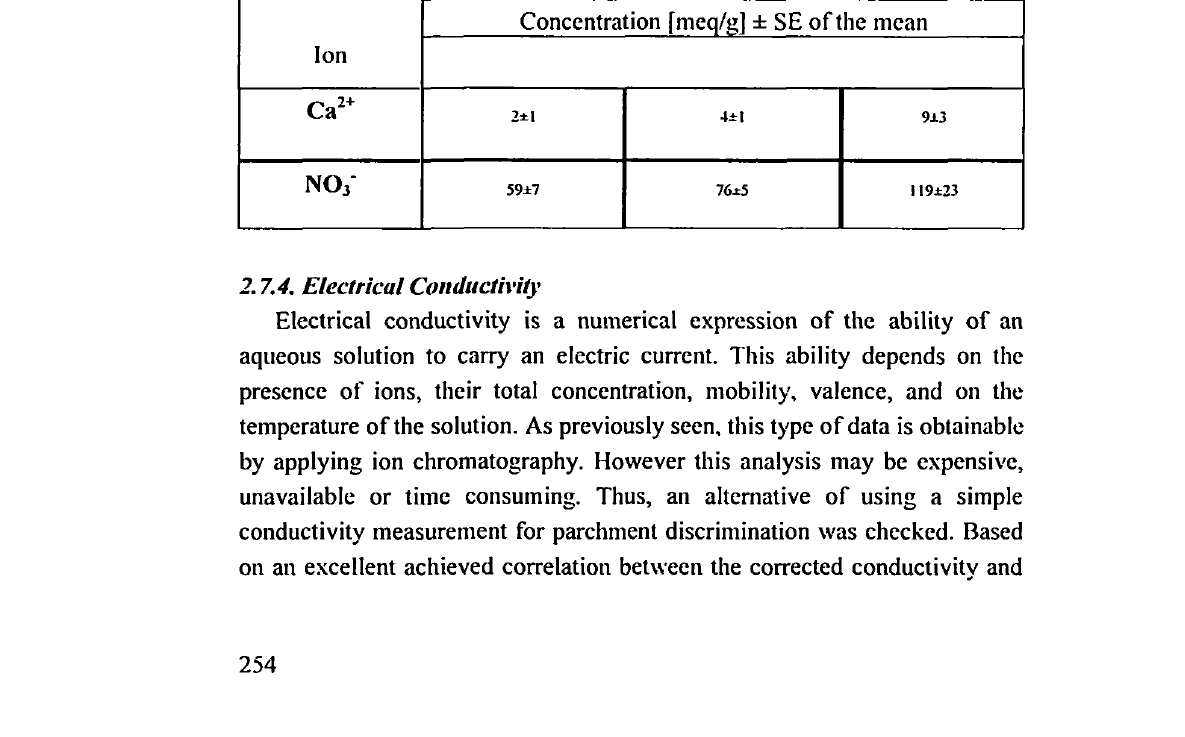
Marker ions for animal type